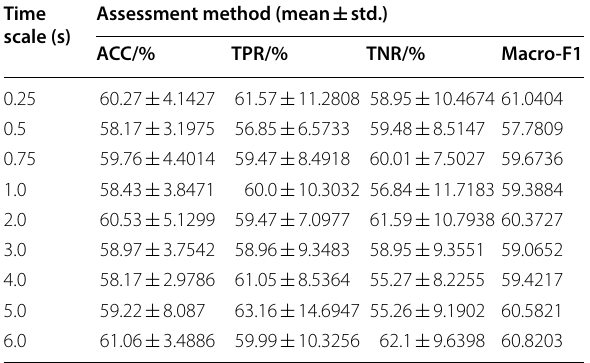
Table 2 The classification results of RT‑ERM with different time scales for α rhythm under the dimension of emotion valence Time Assessment method (mean std.) ± scale (s)